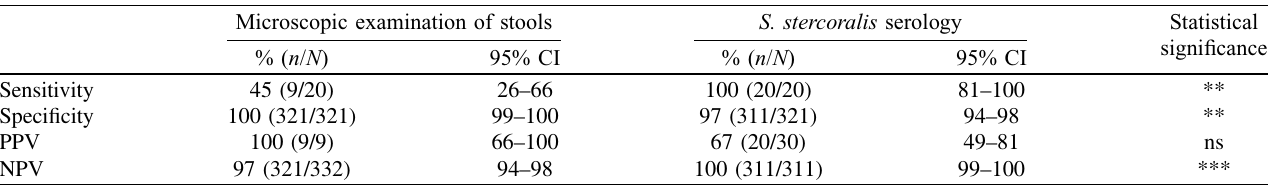
Table 4. Performance of serology and microscopic examination of stools for the diagnosis of strongyloidiasis ( N = 20 proven/probable and 321 negative/possible